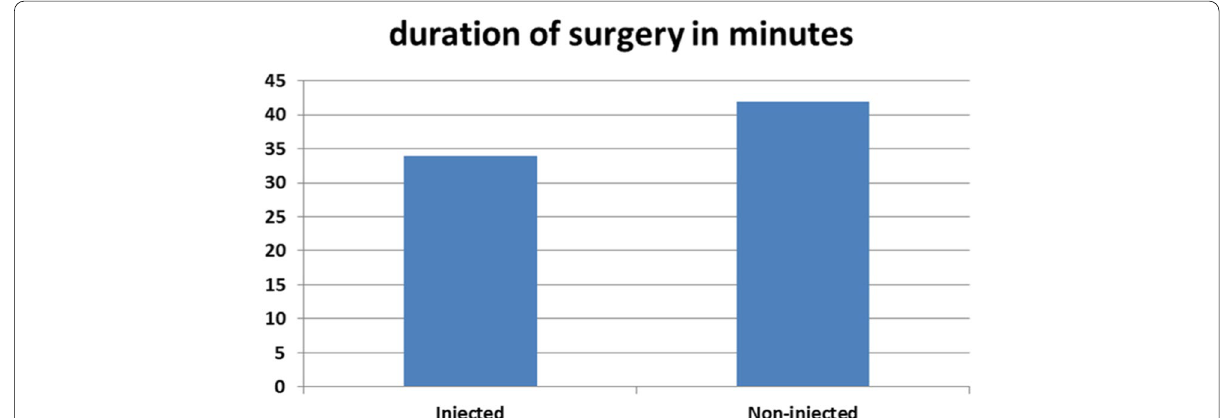
Fig. 5 Comparison between injection and non‑injection side as regards duration of surgery